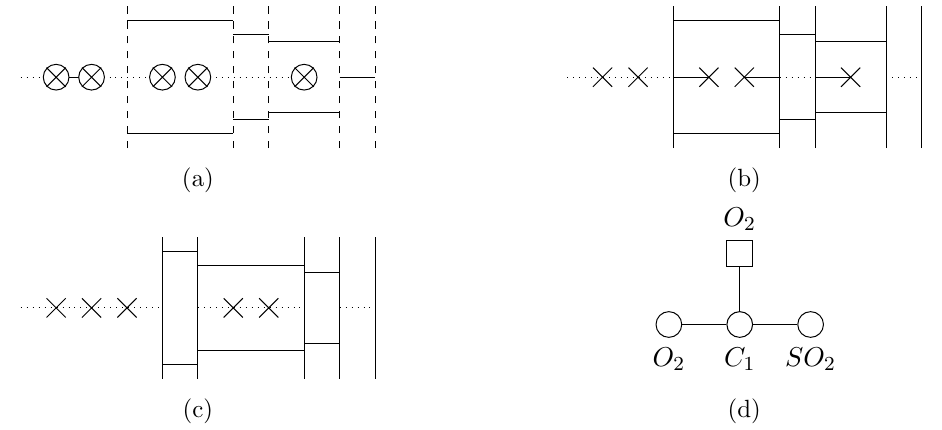
Figure 36. S-duality on the model for the next to minimal orbit of so (5). The parameters of the initial model are n s = n d = 5, ~l d = (4 ; 4 ; 4 ; 4 ; 4), ~l s = (0 ; 0 ; 0 ; 2 ; 2) and rightmost orientifold plane O 3 (cid:0) . (a) Higgs branch of the initial model. (b) Resulting model after performing S-duality on (a). (c) Resulting model after performing the collapse transition on (b). (d) Quiver obtained